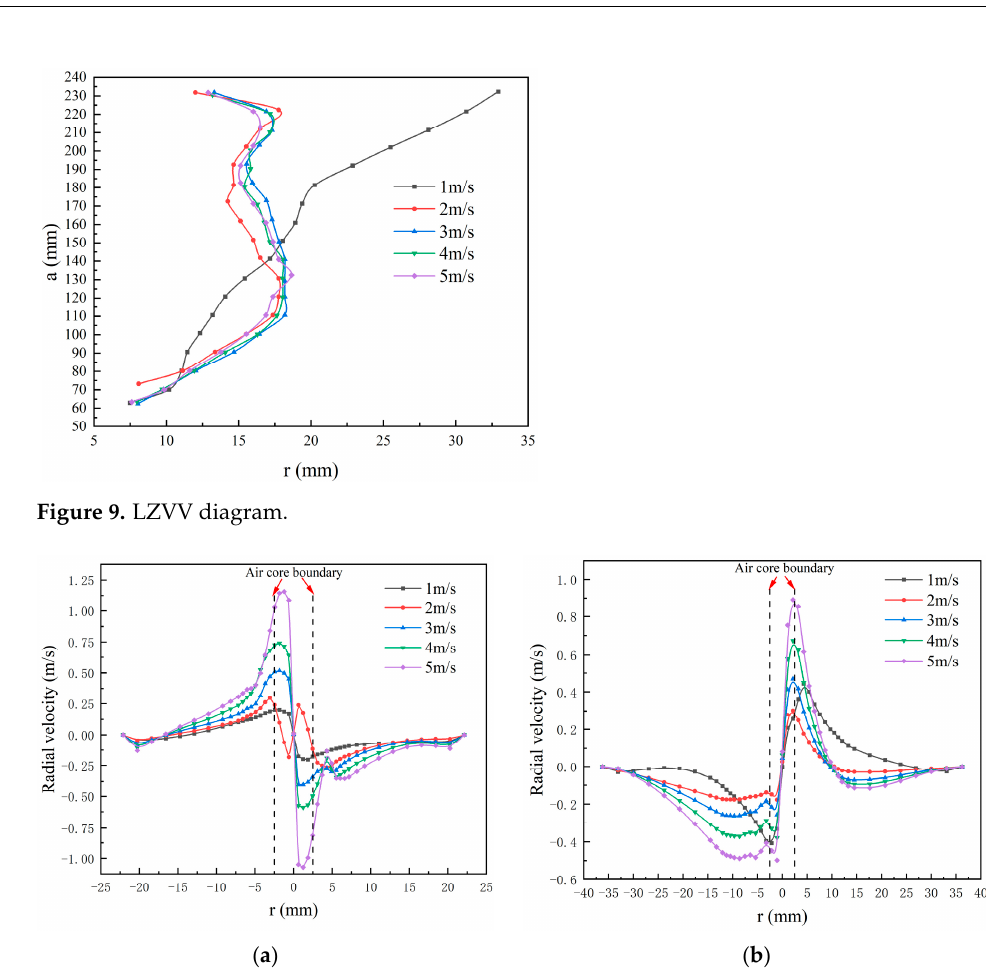
1 = 90 mm; ( b ) z 2 = 170